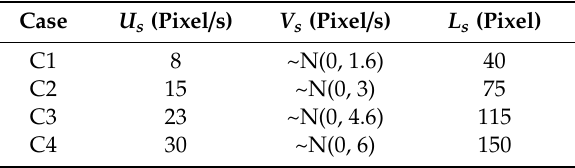
Table 1. Summarizes the major parameters of the simulated